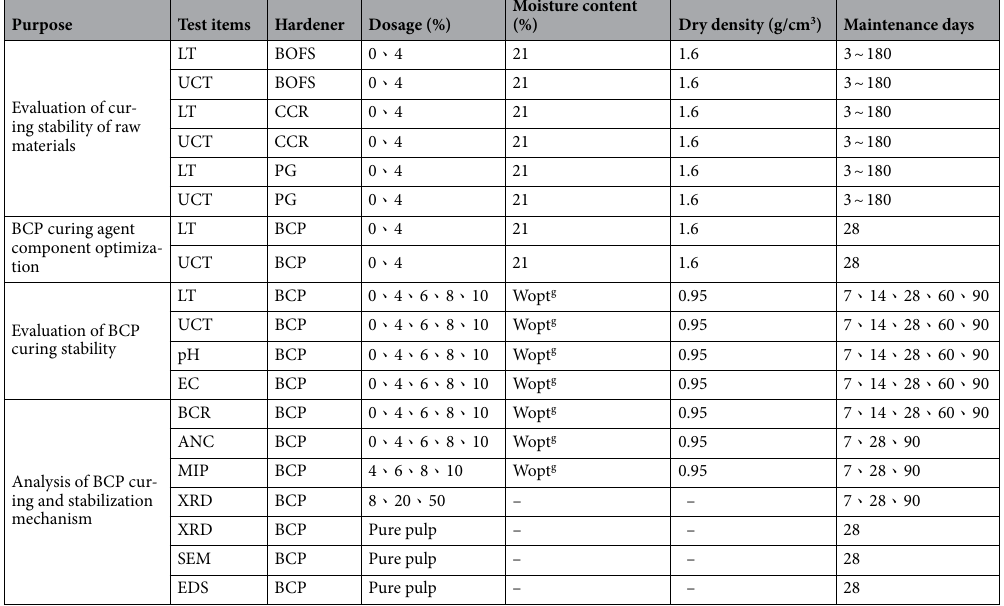
Table 4. Experimental sample preparation control parameters for different